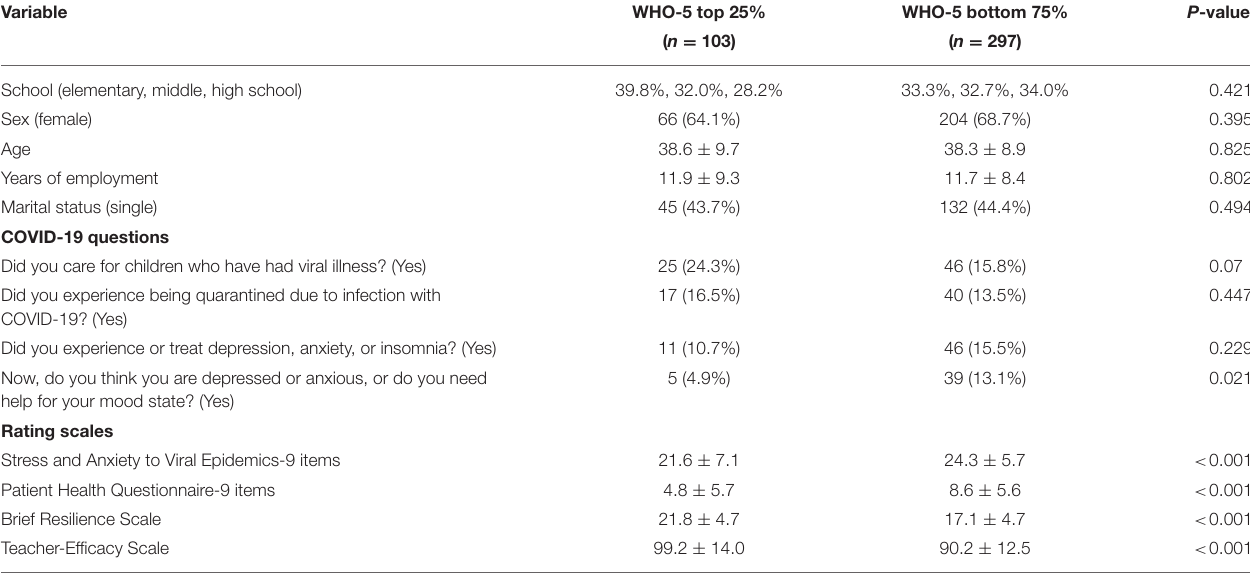
TABLE 3 | Comparison of demographic variables and rating scale scores between the low and high subjective well-being groups ( N = 400). Variable